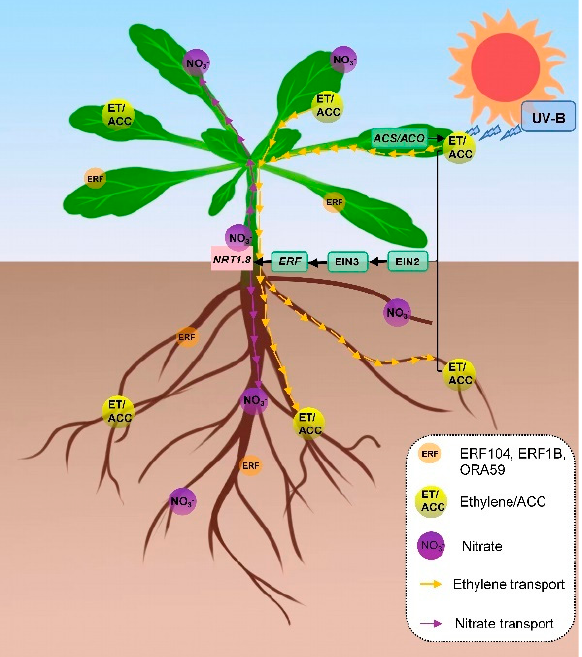
Figure 6. Potential module of the UV-B signaling pathway for regulating nitrate reallocation from hypocotyls to leaves and roots. UV-B signaling is initiated by inducing gene expression of ACSs and ACOs in shoots, which results in ethylene/ACC biosynthesis in shoots and thus promotes ethylene/ACC movement from shoots to roots. Ethylene activates the ERFs-NRT1.8 signaling module in both shoots and roots via EIN2- and EIN3-dependent manners and thus promotes nitrate reallocation from hypocotyls to leaves and roots.